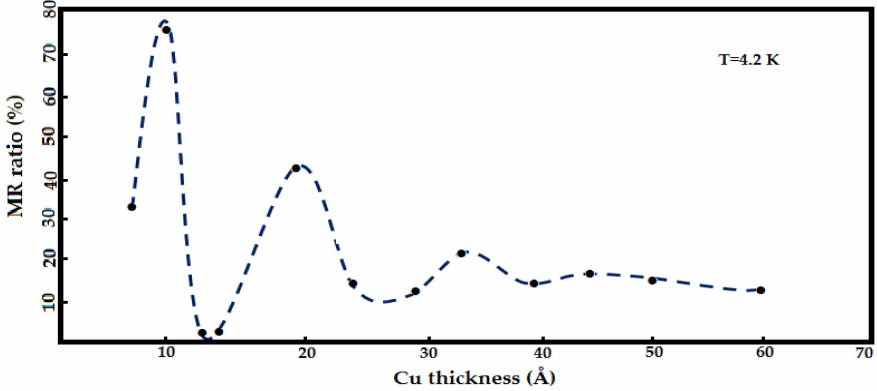
Figure 14. Variation of the MR ratio as a function of the Cu thickness by George et al.